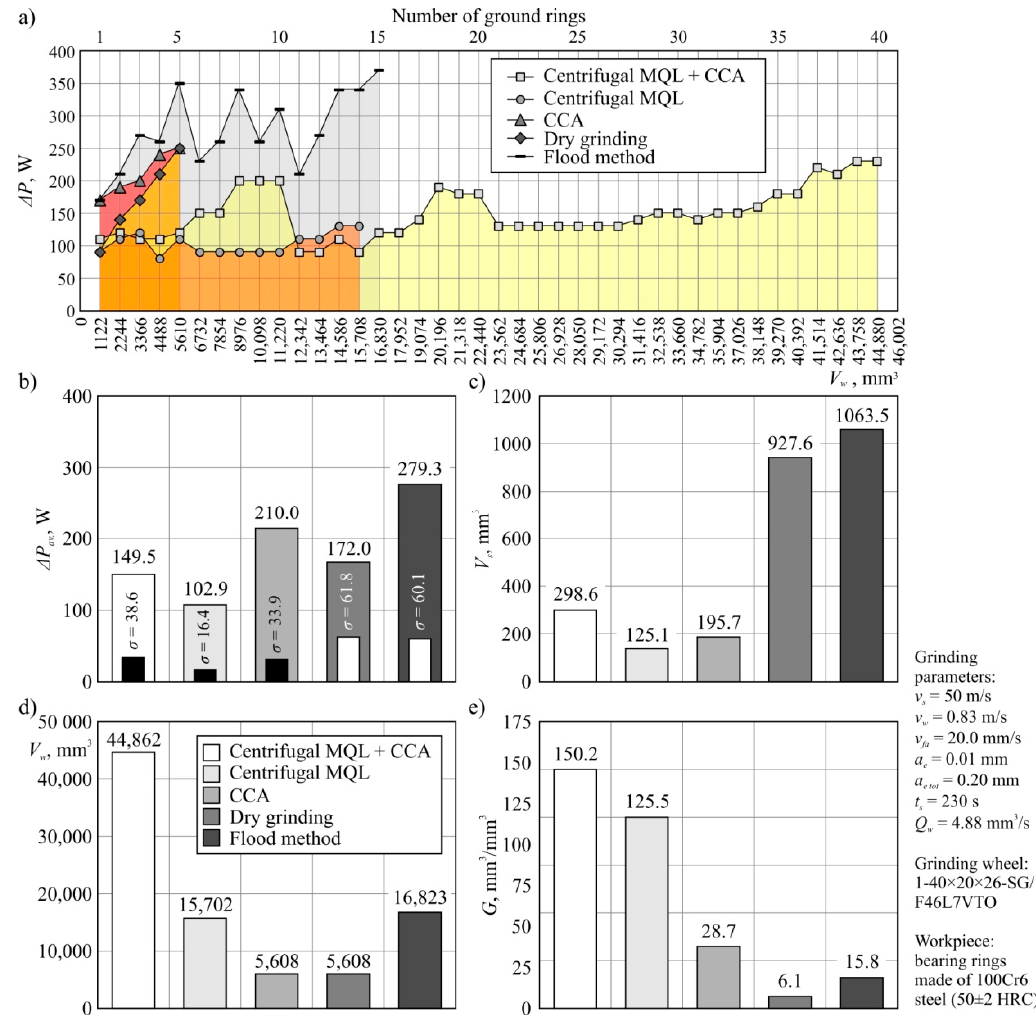
Figure 3. Grinding power gain Δ P values and values of parameters describing the tested grinding wheels’ lifespans: ( a ) grinding power gain Δ P ; ( b ) average grinding power gain Δ P av with the standard deviation σ ; ( c ) material removal V w ; ( d ) volumetric grinding wheel wear V s ; ( e ) grinding ratio G = V w / V s.